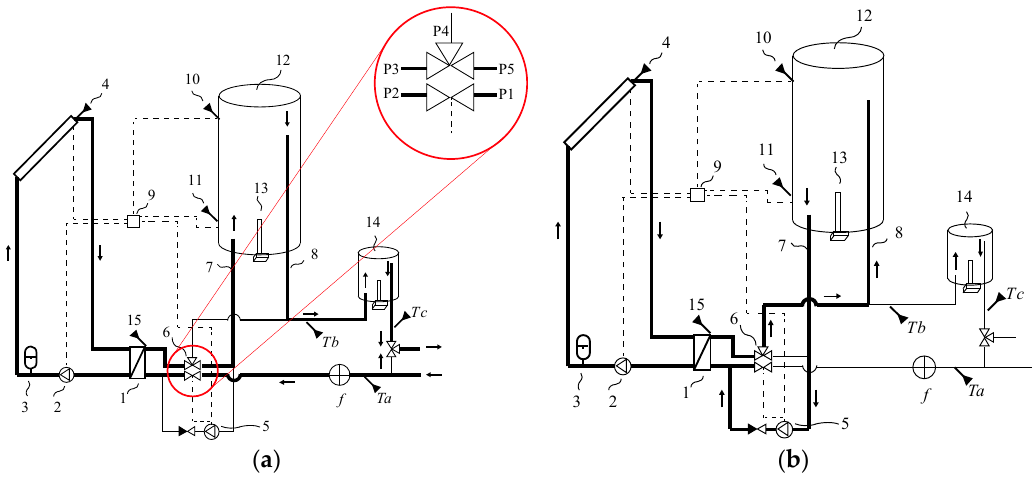
Figure 2. Flow schematics and monitored measuring points during: ( a ) domestic hot water discharge and ( b ) solar charge. Table 1. Description of the components that comprise the entire retrofitted system.